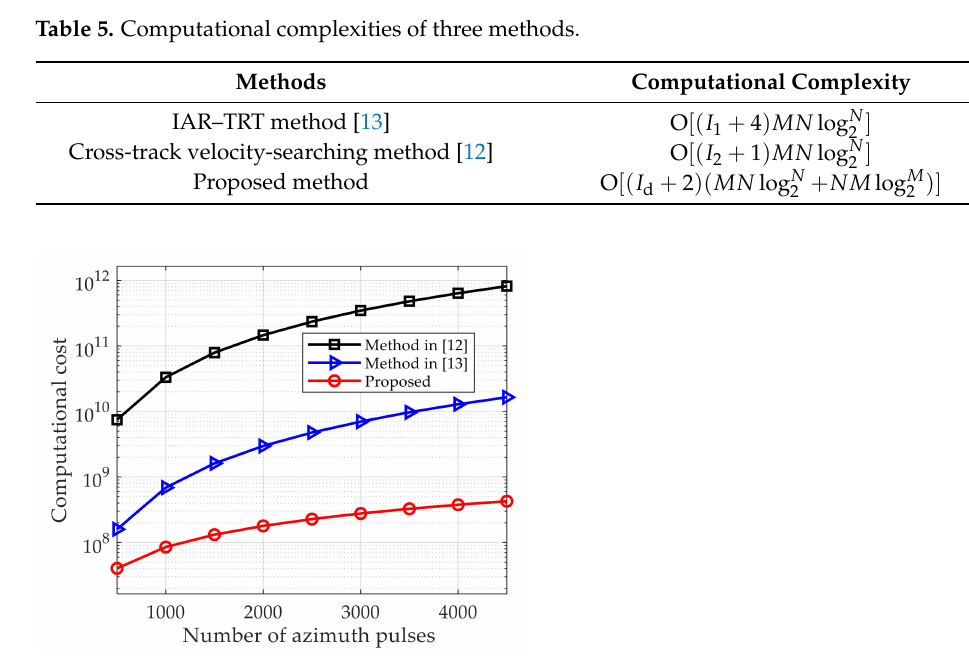
Figure 8. Curves of computational cost vs. the azimuth pulse number for three